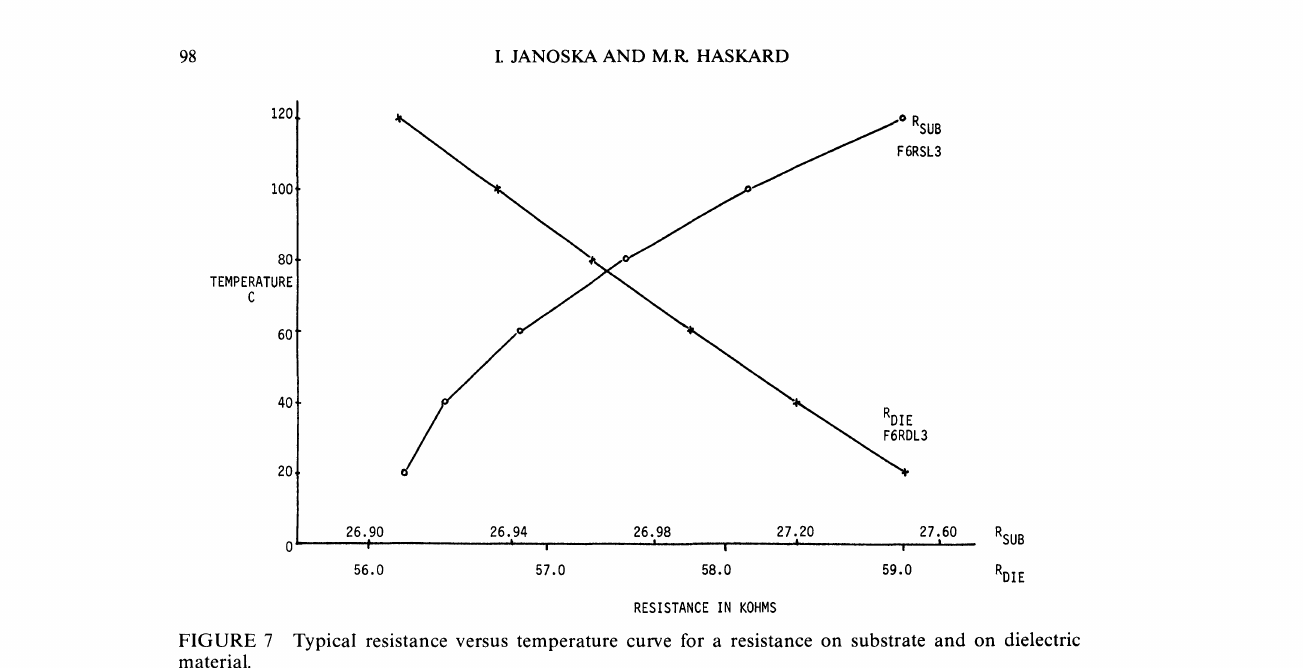
FIGURE 7 Typical resistance versus temperature curve for a resistance on substrate and on dielectric